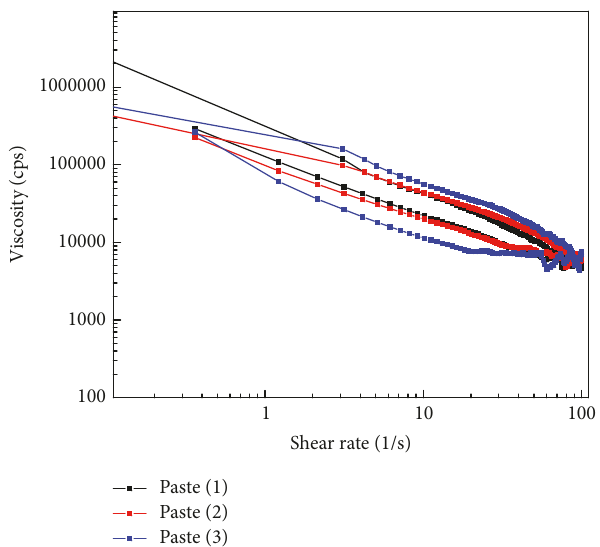
Figure 4: Viscosities versus shear rate plot of Ag